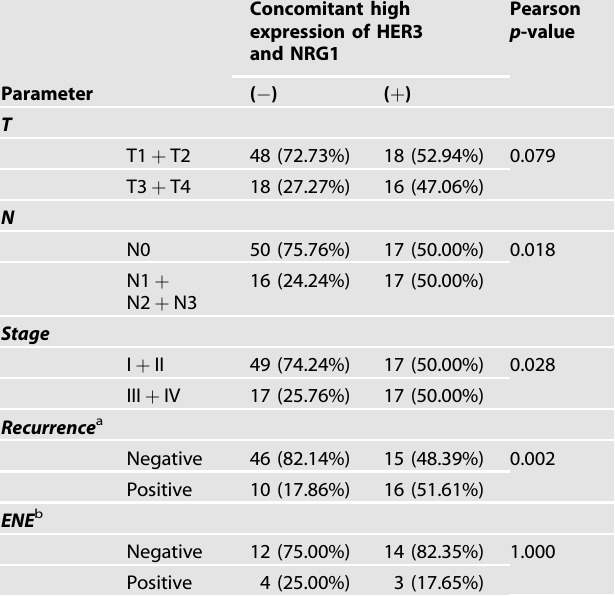
Table 1. Clinicopathological correlation of concomitant high expression of HER3 and NRG1 and OSCC